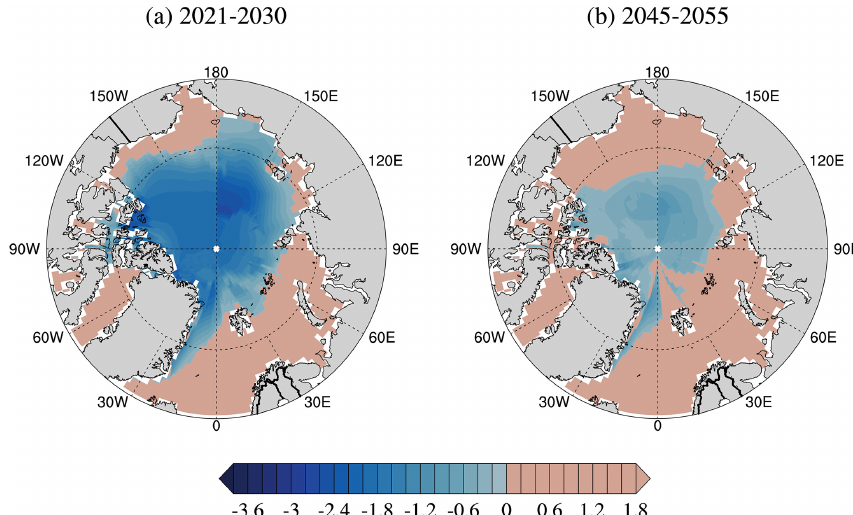
Figure 6. INs for OW ships under SSP5-8.5 in September.